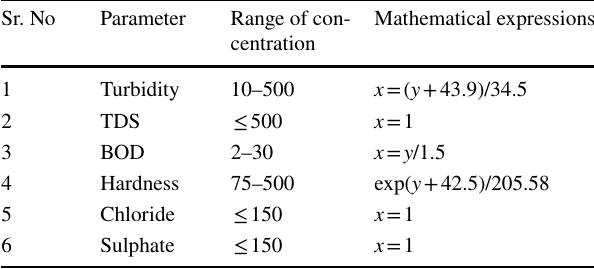
Table 2 Mathematical expressions for function curves for